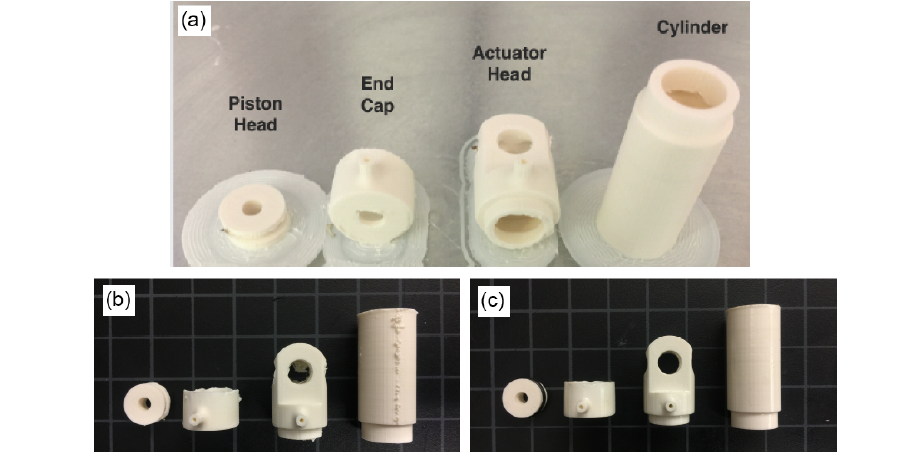
Figure 2. ( a ) The orientation of the different sub-systems of the actuator during 3D printing, ( b ) parts before surface finishing, and ( c ) after surface finishing with